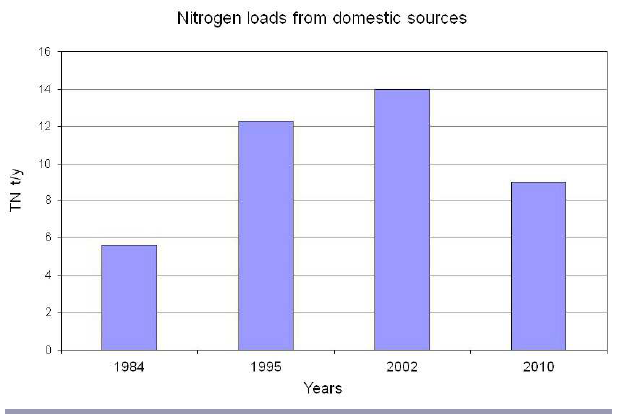
Fig. 4. Variability of total nitrogen loads from domestic sources (1984–2010) discharged into Izmit